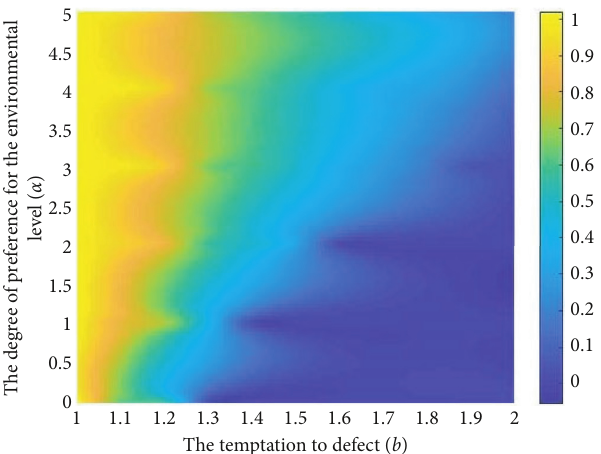
Figure 9: The colour-coded (see the bar on the right) density of cooperation ρ c on the α − b parameter plane. The depicted are obtained in the PDG for u � 0.2. The yellow shading corresponds to the higher stationary density of cooperators at each particular combination of α and b .